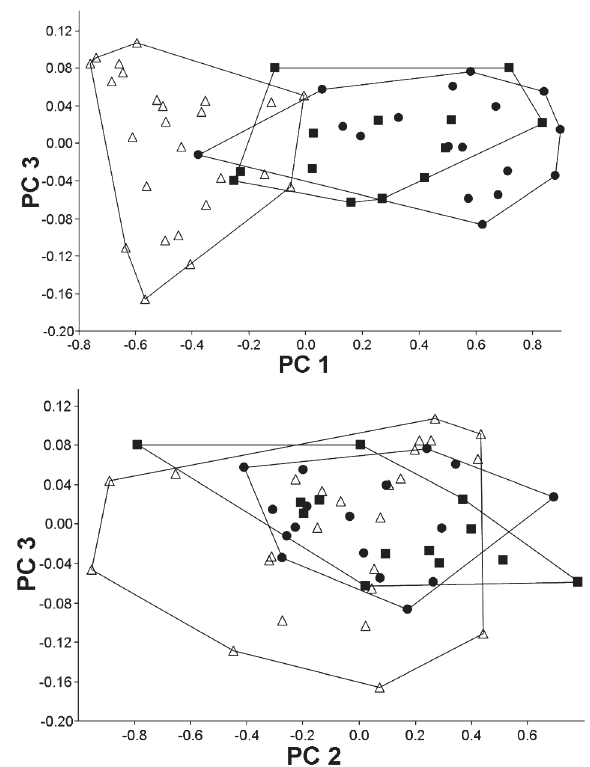
Fig. 4. Plots of factor scores of principal component analysis of three populations of Aspidoras albater , excluding measurements related to eye reduction (horizontal orbital diameter, least interorbital distance, and snout length). Circle, Anésio III Cave; Square, Russão II Cave; triangle, epigean